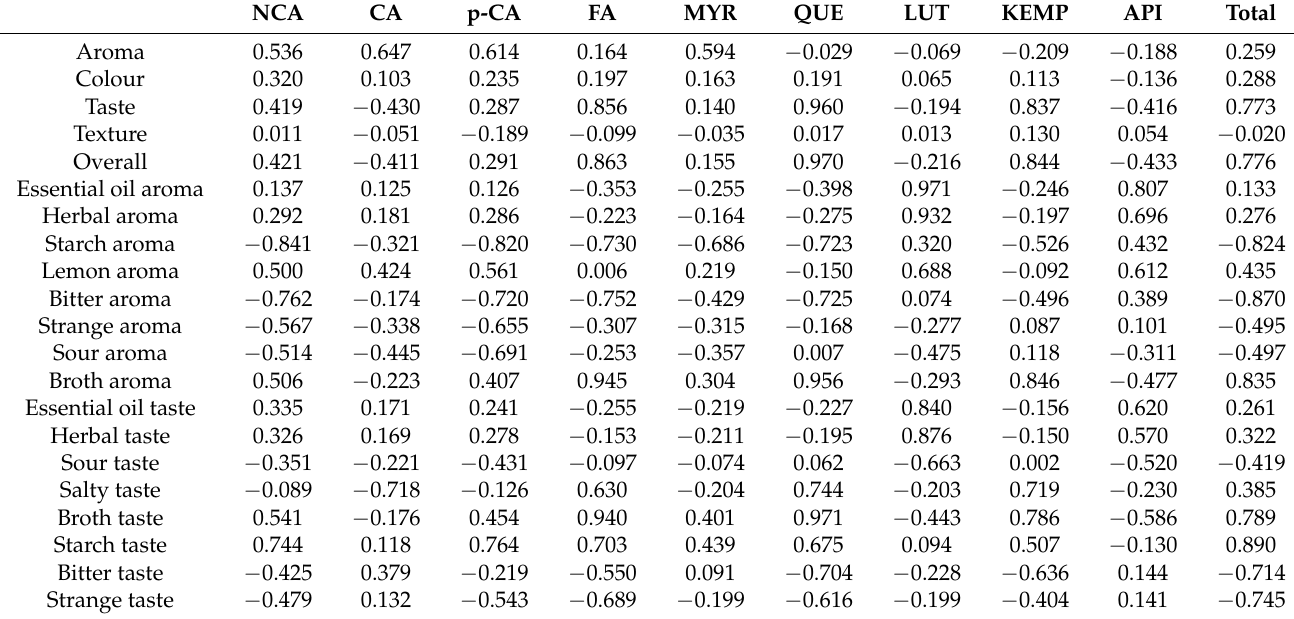
Table 5. Correlations coefficients between sensory parameters and the content of phenolic compounds of extruded snacks with addition of fermented red bean or broad bean seeds/hulls and with herbs/species (0.5%), and the controls (without herbs/spices